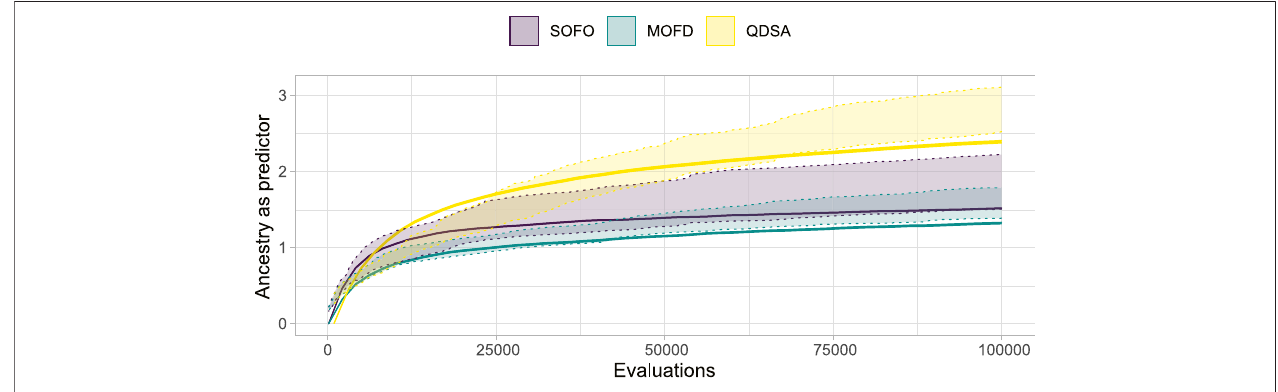
FIGURE 14 | Using Quality Diversity metrics of ancestry to predict maximum fi tness of each search algorithm. The dotted area represents the 95% con fi dence intervalofmaximum fi tness,asshownin Figure4 ,andthelinerepresentstheestimated fi tnessbasedonalinearmodelofQualityDiversitymetricsofancestry.Thelinear model achieves an R 2 of